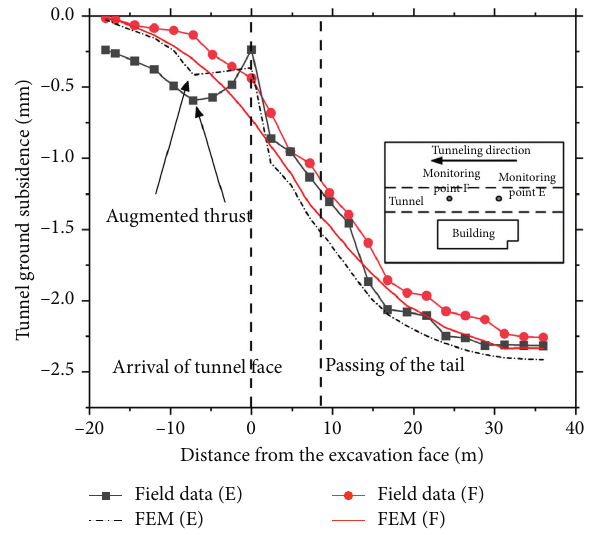
Figure 12: Comparison of surface subsidence simulation and total station monitoring results.